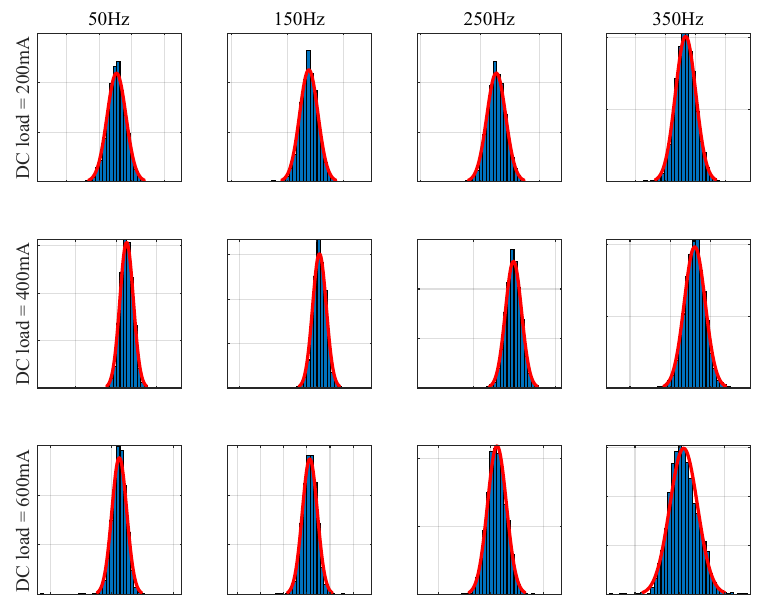
Figure 5. Histogram fits of lognormal distribution for different harmonics and different DC load levels.